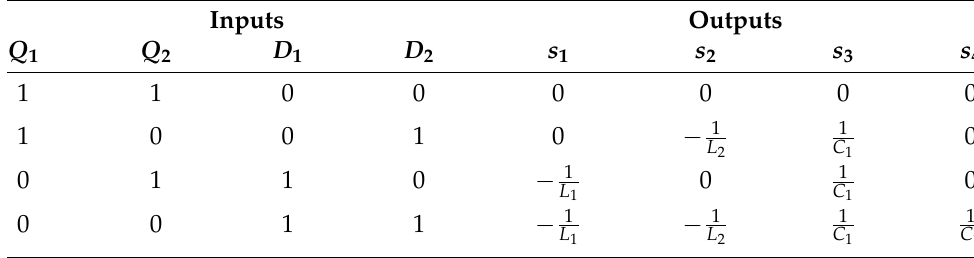
Table 1. IBC activation modes that render different variants of